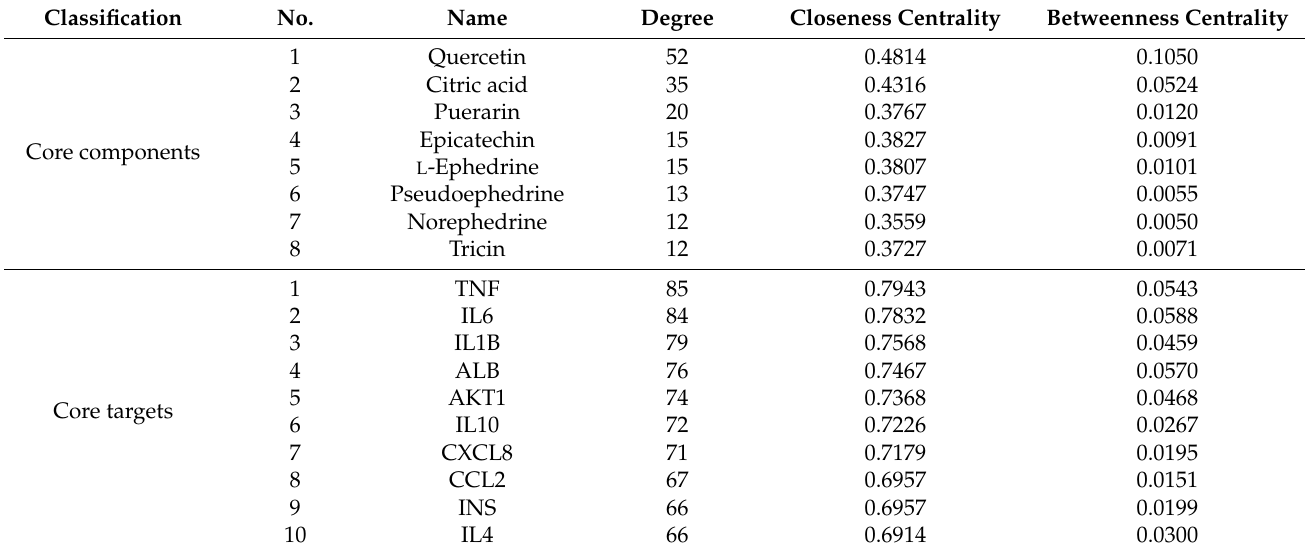
Table 3. The 8 core components and 10 core targets of HEH in disease